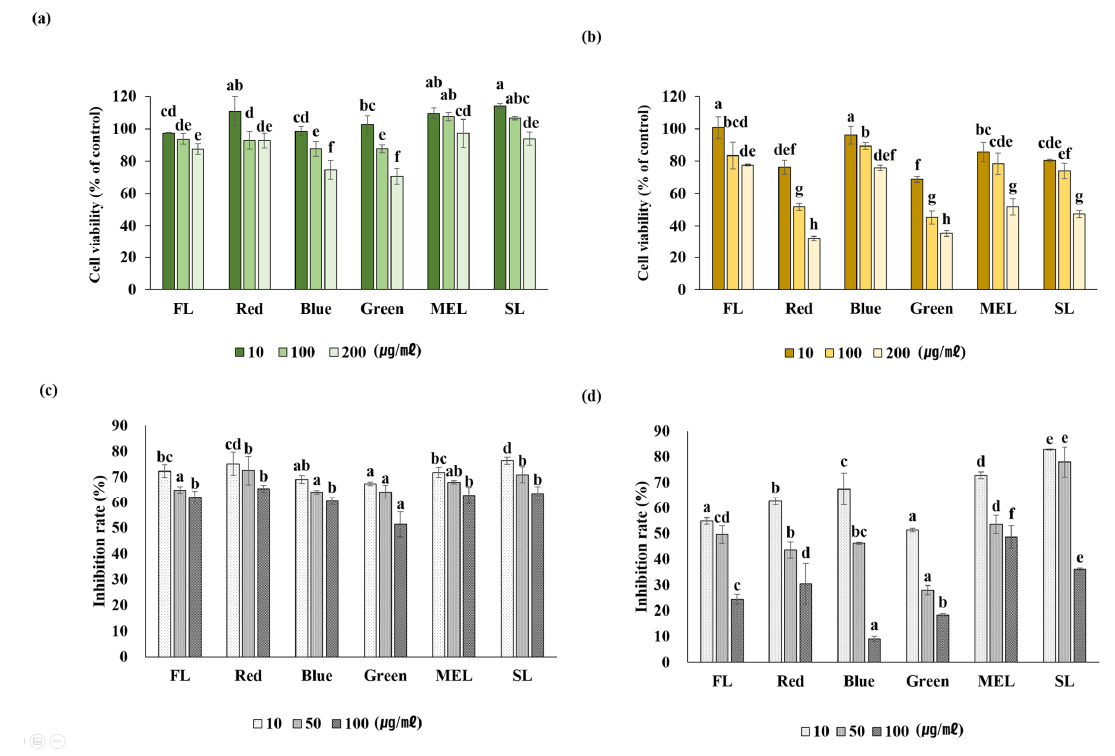
Figure 6. Cell viability ( a , b ) by MTT assay and NO production ( c , d ) in LPS-induced Raw 264.7 cell with Dachul extracts. ( a , c ); aerial part of Dachul, ( b , d ); underground part of Dachul.